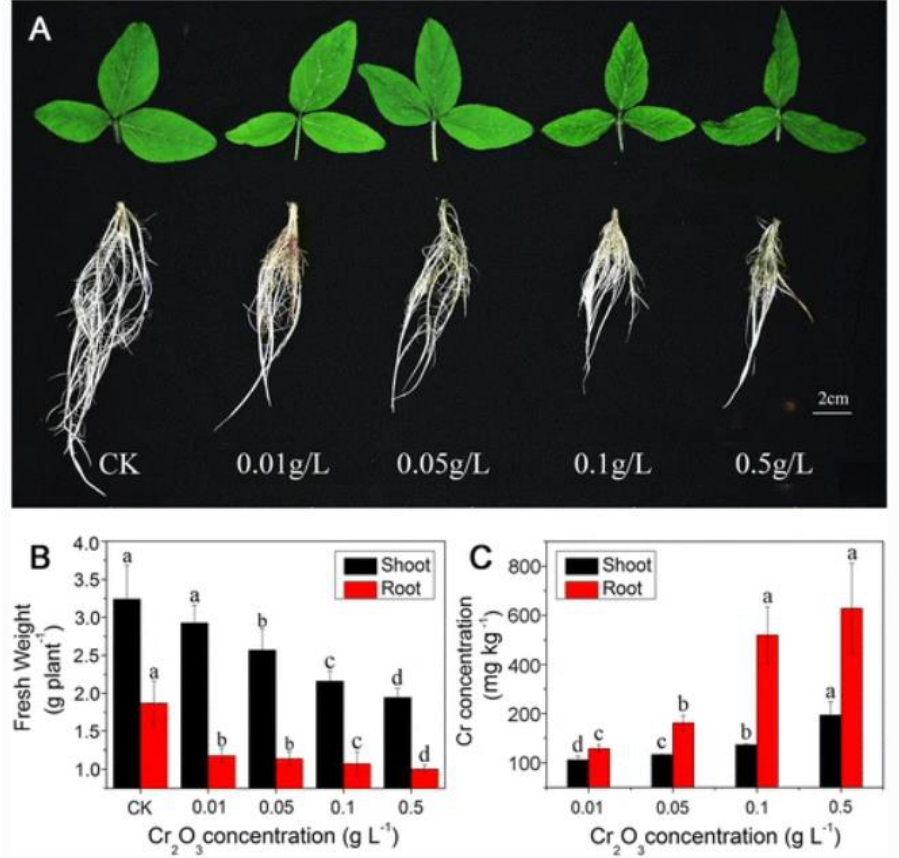
Figure 5. Effect of chromium oxide nanoparticle treatment on soybean plant growth ( A ), biomass ( B ), and Cr content in shoot and root ( C ). Soybean plants were treated with different Cr 2 O 3 NP lev- els. Bars with different letters are significantly different at p < 0.05. Reprinted with permission from [76]; copyright (2013), Springer Nature.